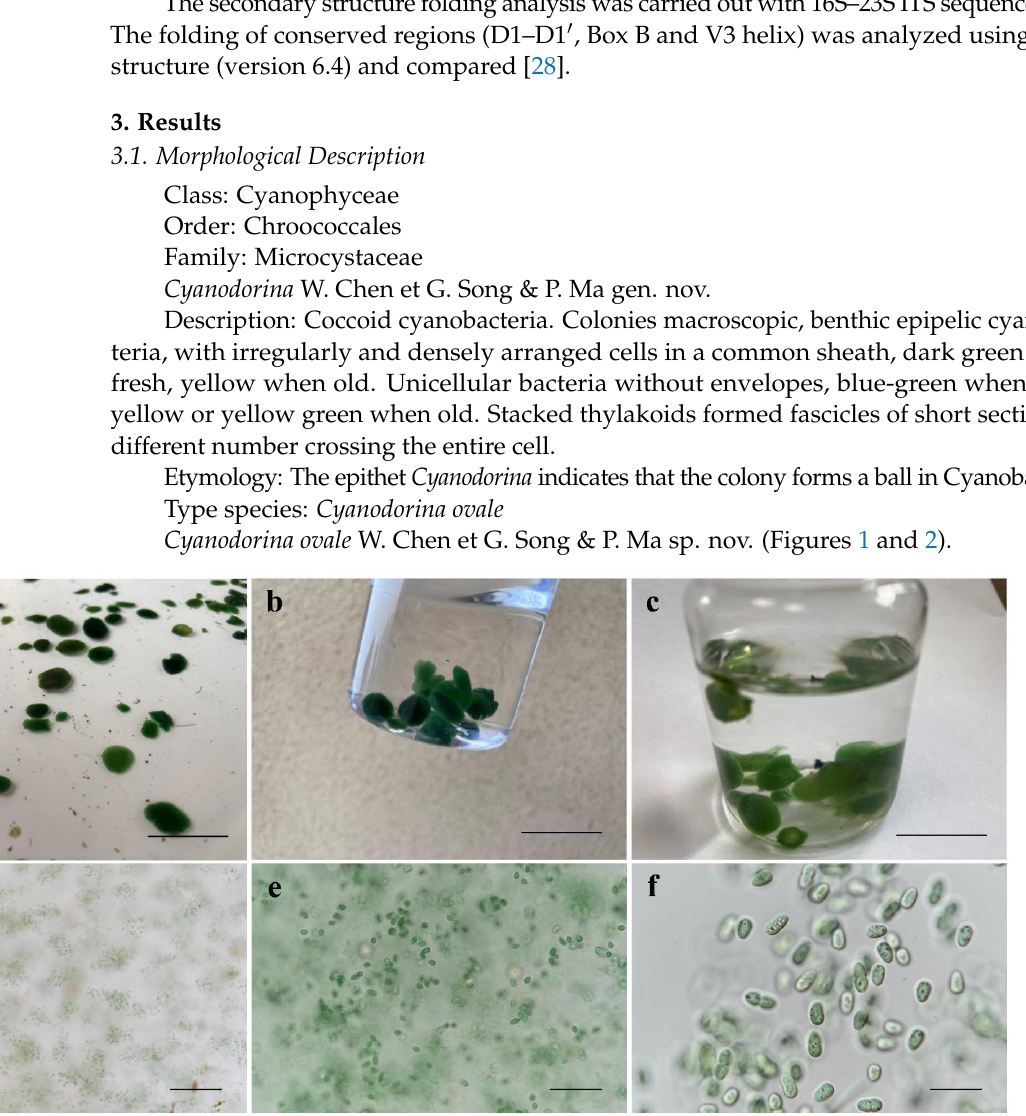
Figure 1. Field sample morphology of Cyanodorina ovale. ( a ) Cyanodorina ovale in the tray after sediment cleaning. ( b , c ) Cyanodorina ovale in liquid BG11 medium. ( d – f ) Colonies at different magnification. Scale bars: ( a – c ) 2 cm, ( d ) 200 µm, ( e ) 50 µm, ( f ) 20 µm.